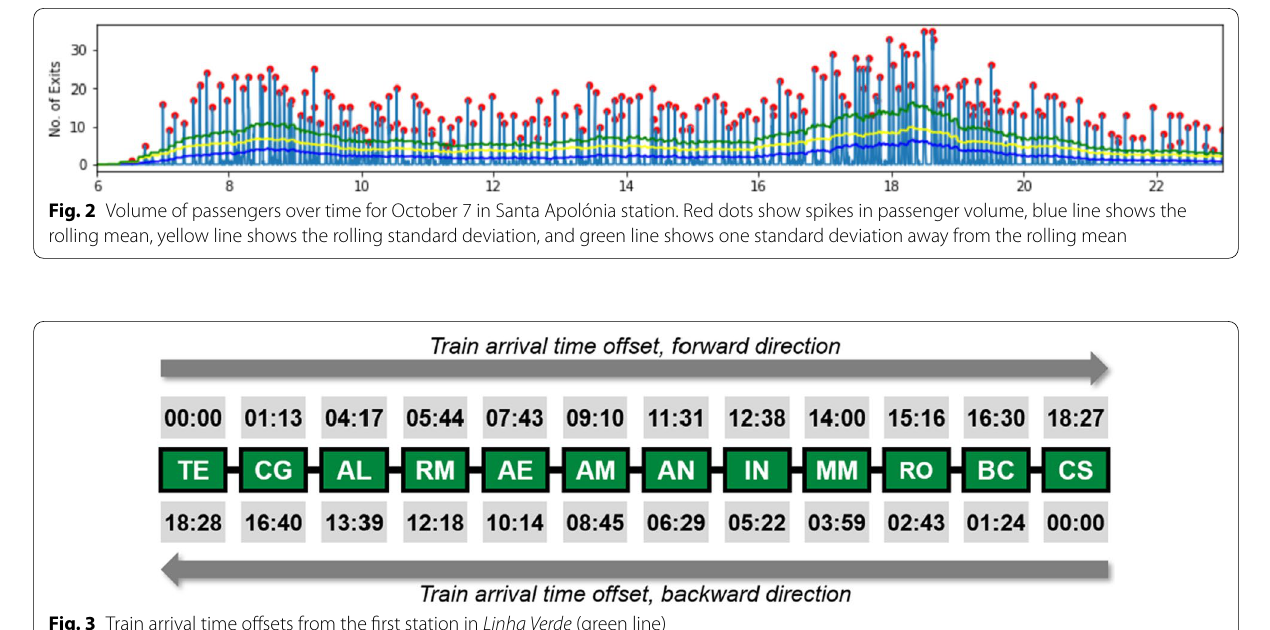
Fig. 3 Train arrival time offsets from the first station in Linha Verde (green